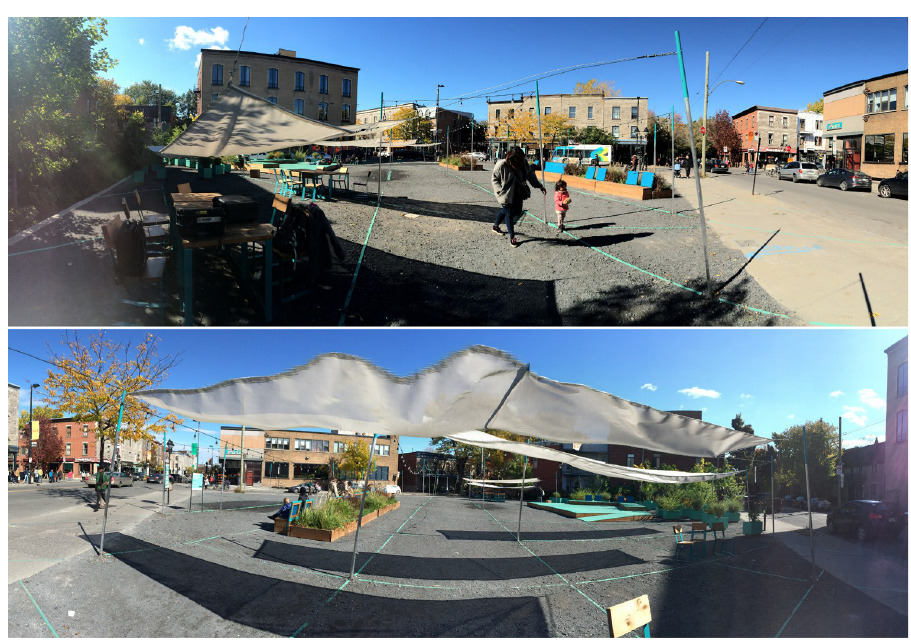
Fig 3. Panoramic photographs of the space presented at the beginning of the laboratory experiments. Top: location A; bottom: location C (original copyright: Mariana Mejı´a Ahrens [2018] under a CC BY 4.0 license).